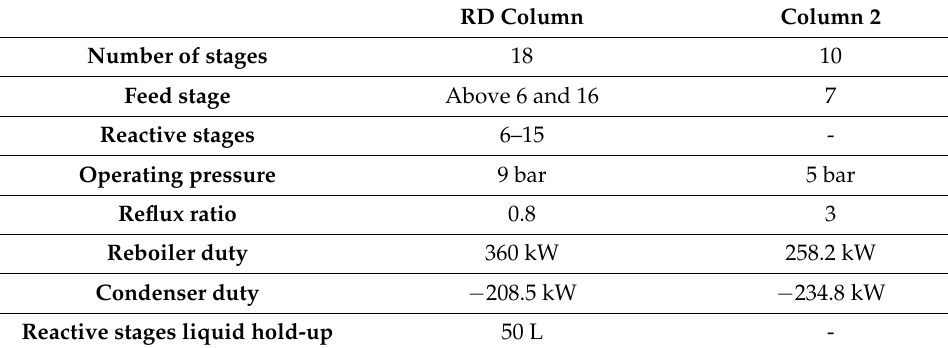
Figure 3. Detailed schematic of RD process.